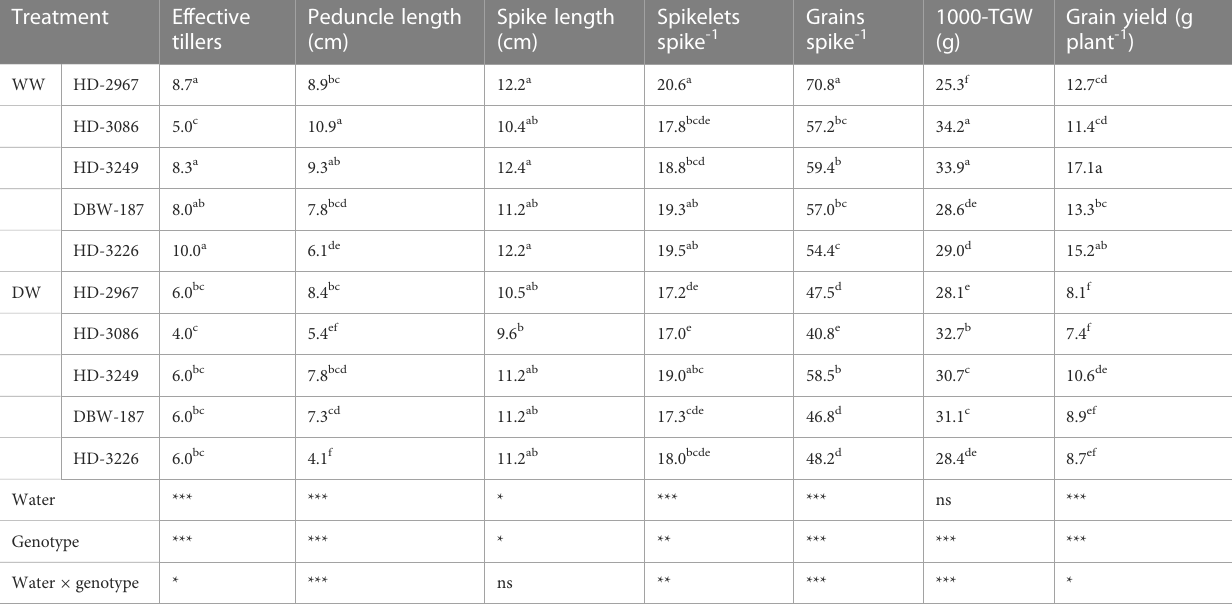
TABLE 1 Yielding traits and grain yield of wheat genotypes grown under well- and de fi cit-watered conditions.